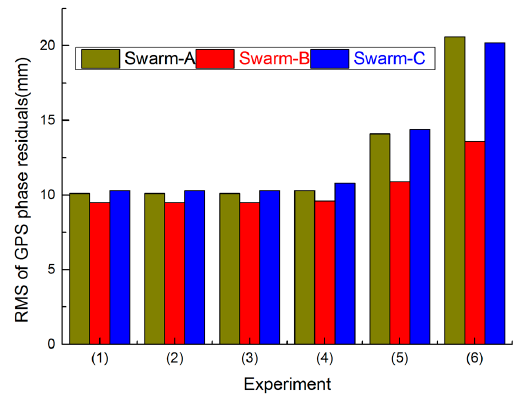
Figure 1. Root Mean Square (RMS) values of GPS phase residuals for all three Swarm satellites on 1 November 2014.